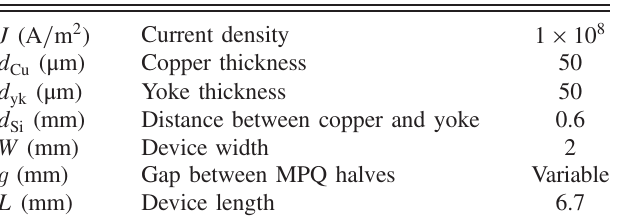
TABLE I. Simulated device parameters.